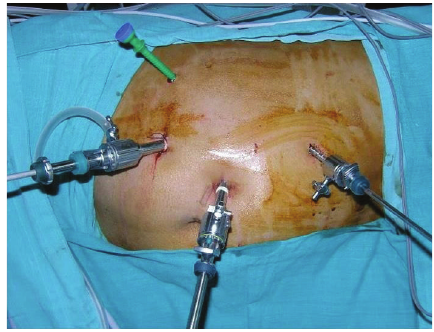
Figure 4: Resected specimen of the right kidney and adrenal with renal tumor